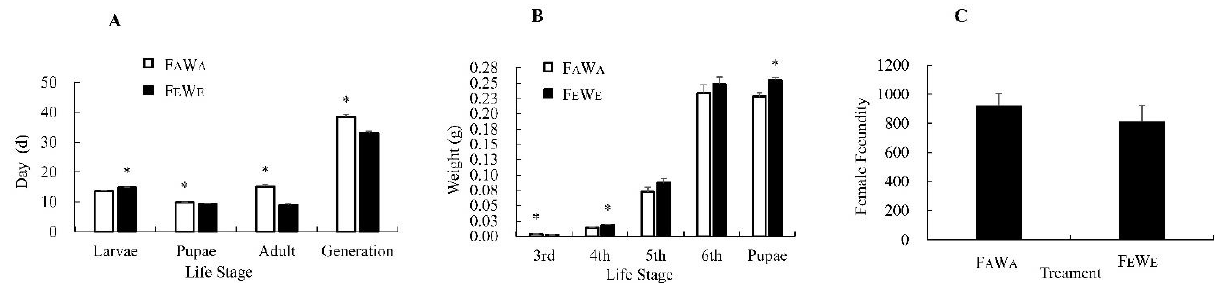
Figure 1. Development period ( A ); larvae weight ( B ); female fecundity ( C ) (Mean ± SE) of F A W A